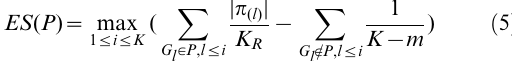
~ 4 and s 2 ~ 1 . p np